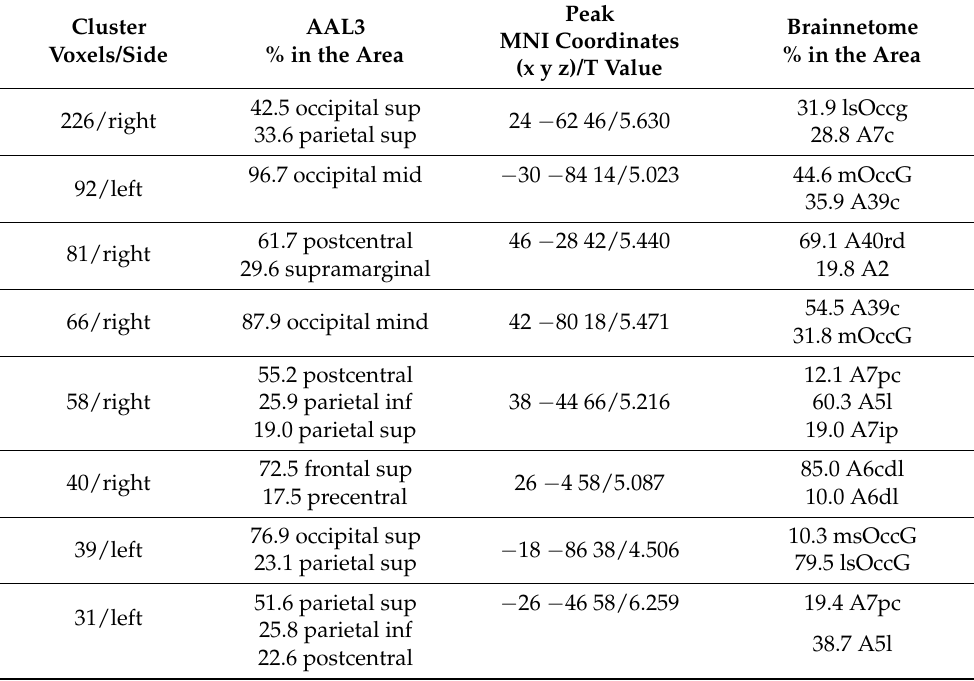
Table 1. Activated areas highlighted by the “SSA > control condition” contrast. The number of voxels is given for each cluster, together with the side (i.e., left or right hemisphere), the cluster composition (i.e., percentage of voxels in each area assigned using AAL3 and brainnetome atlas), MNI coordinates and t value of the peak. Only activated areas covering more than 10% of the cluster are shown. Peak Brainnetome Cluster AAL3 MNI Coordinates % in the Area Voxels/Side % in the Area (x y z)/T Value 42.5 occipital 226/right